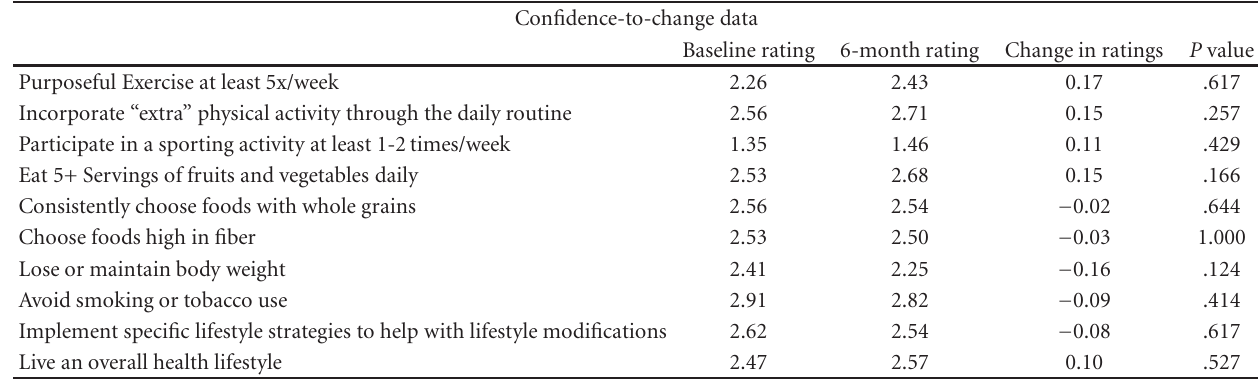
Table 2: Confidence-to-change lifestyle